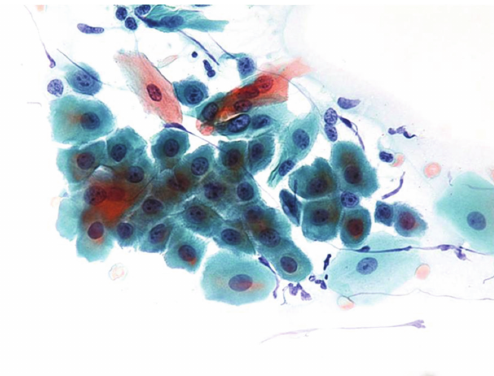
Figure 3: Cytological smear of a ff ected gingiva illustrating a collection of acantholytic Tzank cells.